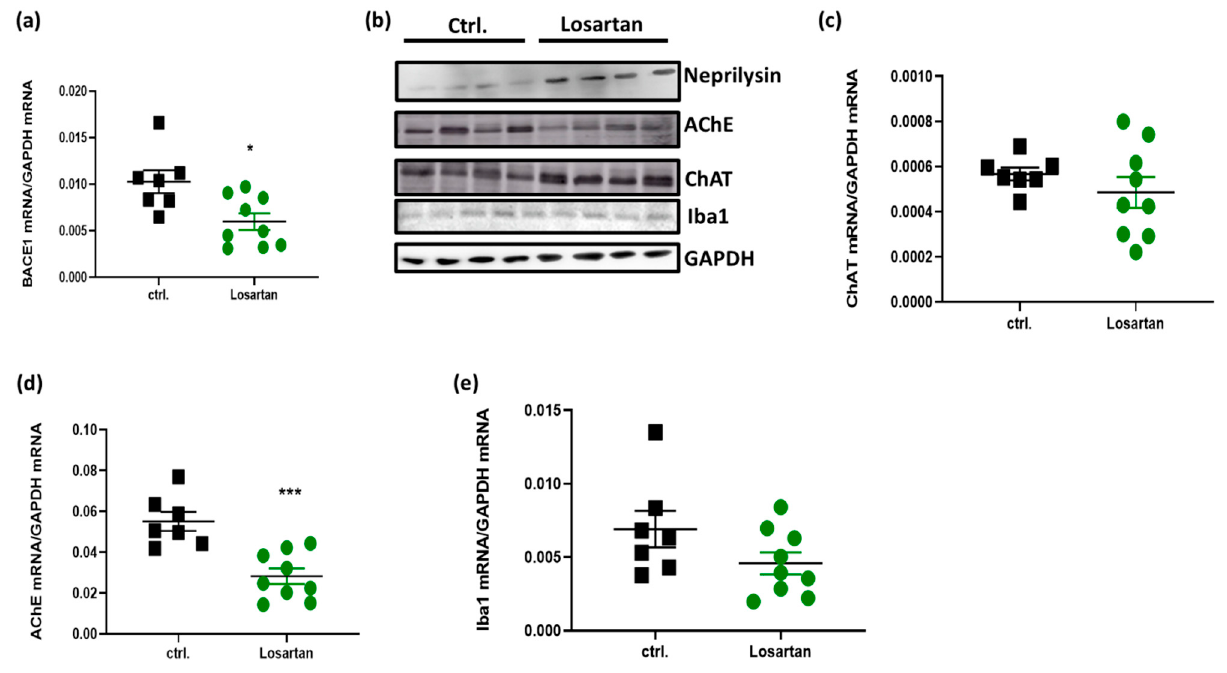
Figure 4. Expression of factors regulating cholinergic activity, A β clearance and microglial function in losartan-treated APP/PS1 mice. ( a ) qPCR of β secretase 1 (BACE1) mRNA ( n = 7 in control and n = 9 in losartan treated group); ( b ) Western blot of neprilysin, Acetylcholine esterase (AChE), Choline acetyltransferase (ChAT) and ionized calcium-binding adapter molecule 1 (Iba1), n = 4; ( c – e ) qPCR of AChE, ChAT and Iba1 mRNA ( n = 7 in control and n = 9 in losartan treated group). Statistical analysis in ( a ) and ( c – e ): t -test, * p < 0.05, *** p < 0.0005.